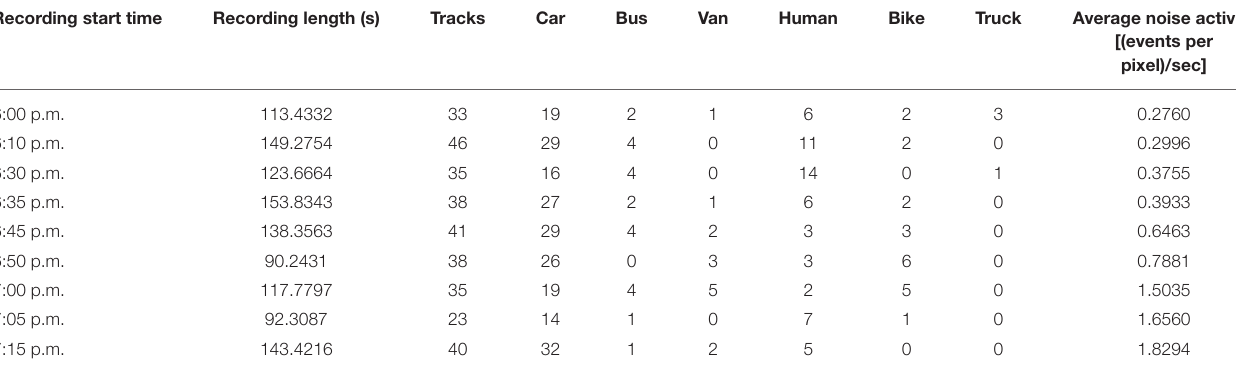
TABLE 1 | Details of the traffic data recorded using ATIS. Recording start time Recording length (s) Tracks Car Bus Van Human Bike Truck Average noise activity